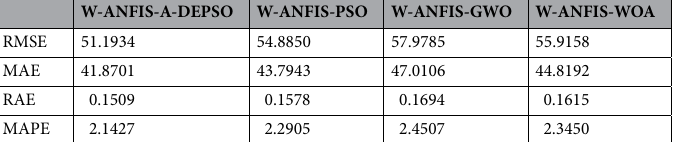
Table 14. Compare W-ANFIS-A-DEPSO with three hybrid models in testing